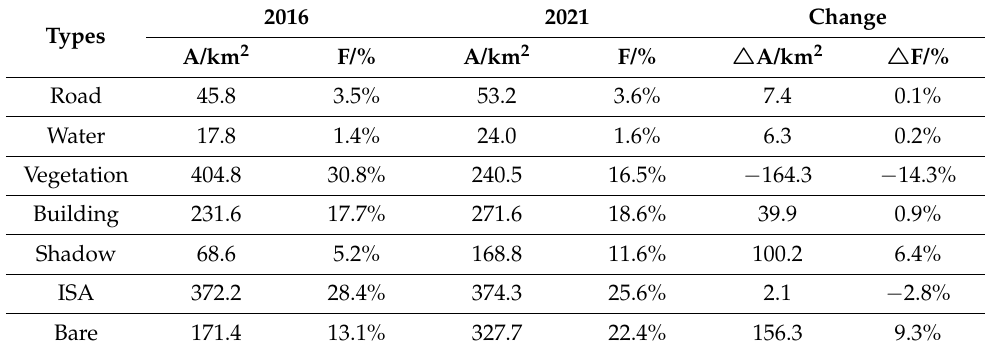
Table 7. Dynamic changes in the urban land cover types between 2016 and 2021.